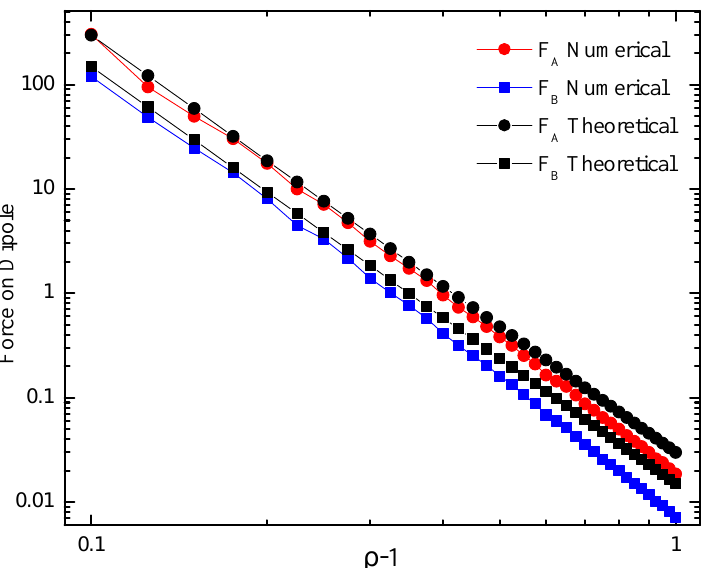
Figure A2. Nondimensional force on dipole versus distance to the cylinder surface. Comparison between numerical force and the theoretical approximation according to Equation